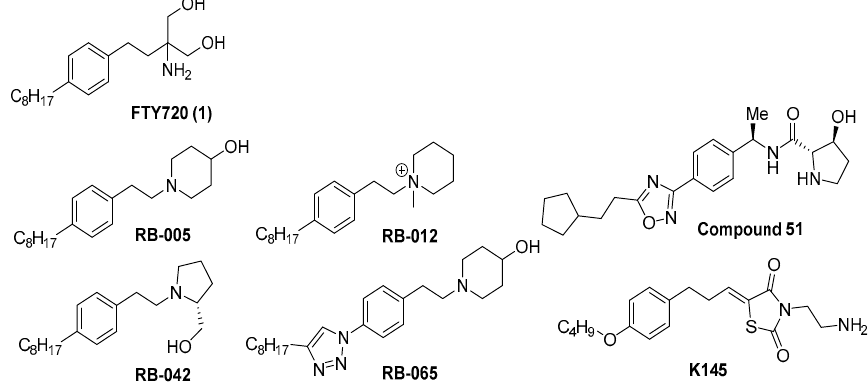
Figure 1. FTY720 ( 1 ) and known biologically active compounds.